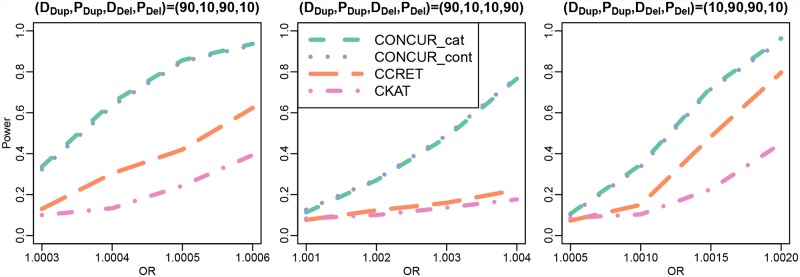
Power comparison between CONCUR, CCRET, and CKAT for TWB-Chr1(b) (causal categorical dosage × length effects in chromosome 1 of TWB data).The panels show power under combined duplication and deletion effects. Different proportions of deleterious vs. protective effects are considered as indicated by (DDup,PDup,DDel,PDel) with DDup and PDup reflecting the proportions of deleterious and protective segments among causal duplication segments, and with DDel and PDel defined similarly for causal deletion segments.